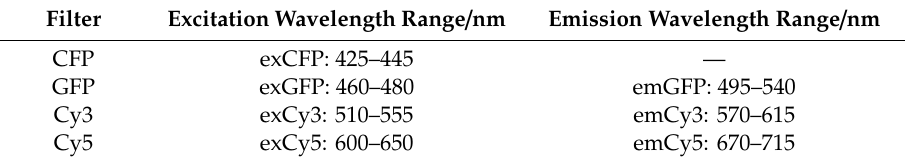
Table 3. The wavelength ranges of